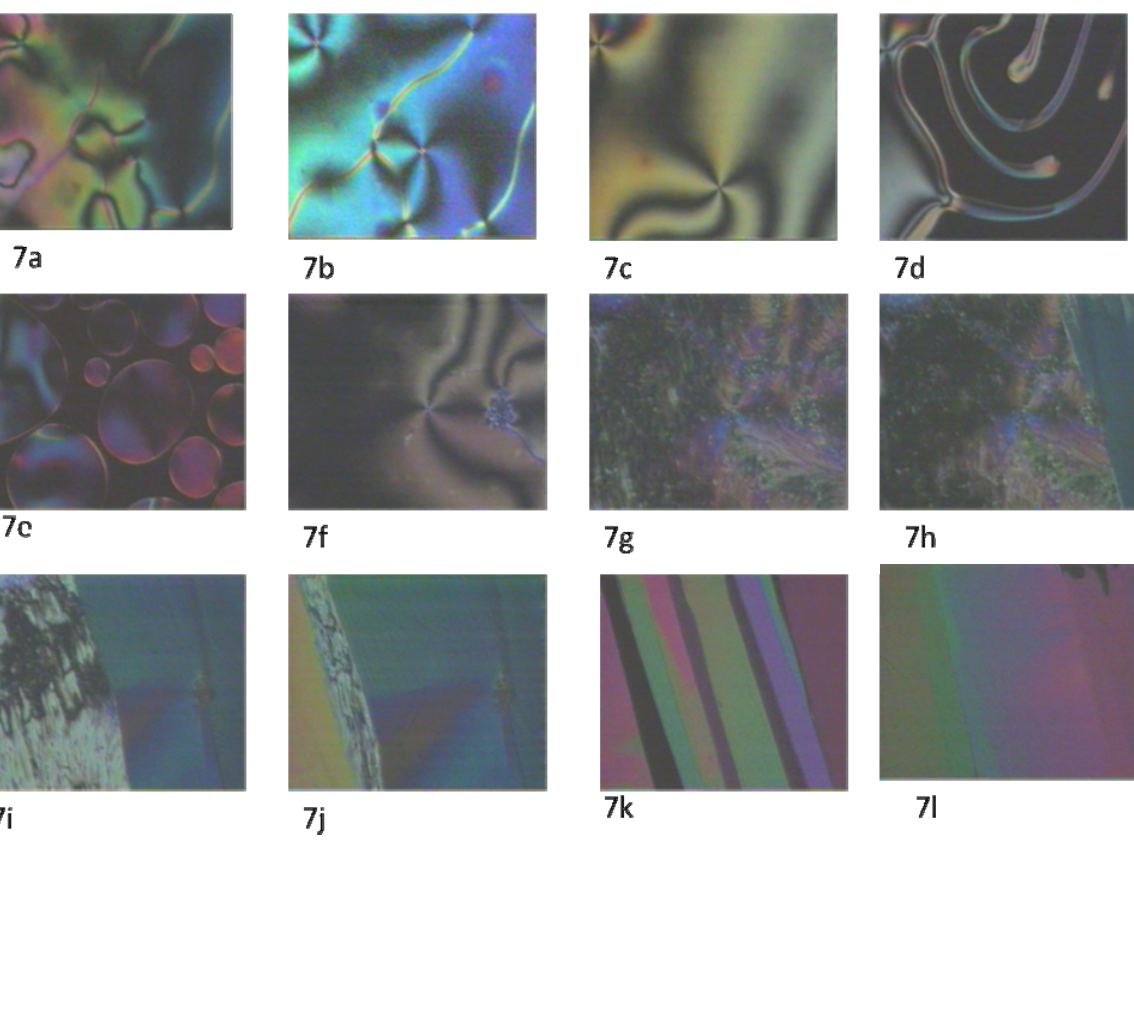
Figure 7. Phase transitions upon heating and cooling when external shear stress is applied under cross polarizer. (7a), (7b), and (7c), Nematic texture with: disclination lines (threads), points with extinction crosses, and wall defects, below 150 ° C; (7d), nematic to isotropic transition, 150 ° C; (7e) nematic droplets coalesce upon cooling, 150 ° C; (7f) nematic Shlieren texture and points with extinction crosses, 145 ° C; (7g) smectic X2 texture upon cooling, 117 ° C; (7h) smectic X2 to smectic X1 transition upon cooling, 103 ° C; (7i), (7j) smectic X2 to smectic X1 transition upon cooling, 103 ° C; (7k), (7l) mosaic texture of smectic X1, 103 °